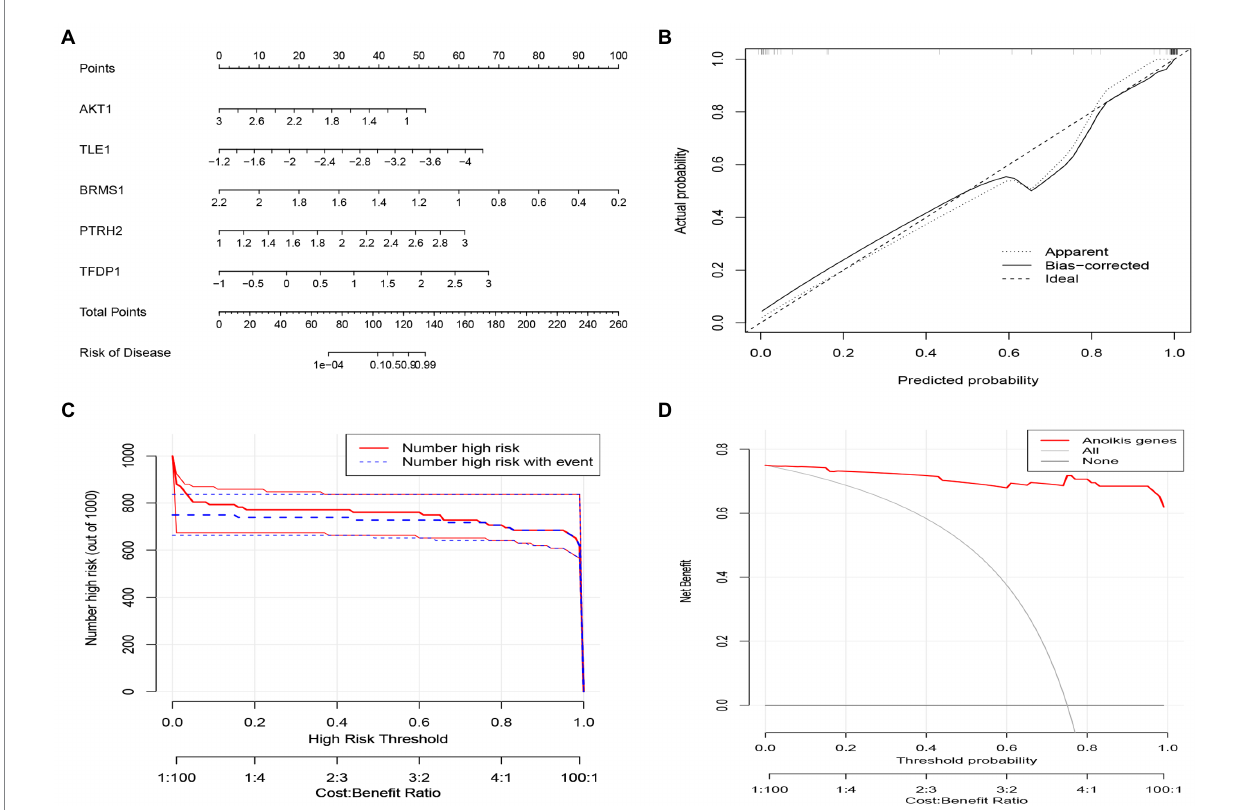
FIGURE 8 Construction of the nomogram model based on Characteristic ARGs. (A) Construction of nomogram integrating Characteristic ARGs for IS. in the nomogram, each variable corresponds to a score, and the total score can be calculated by summing the scores of all variables. (B) Calibration curves to estimate the prediction accuracy of the nomogram. (C) Clinical impact of the nomogram model as assessed by the clinical impact curve. (D) Decision curve analysis showing the clinical benefit of